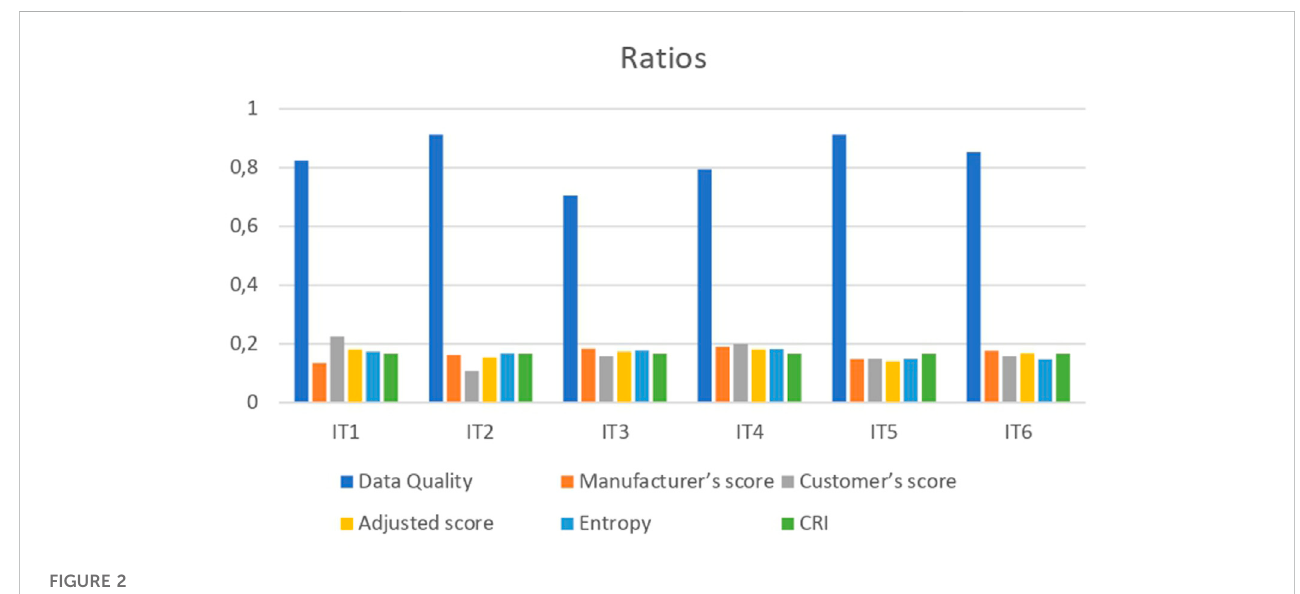
FIGURE 2 Set of ratios